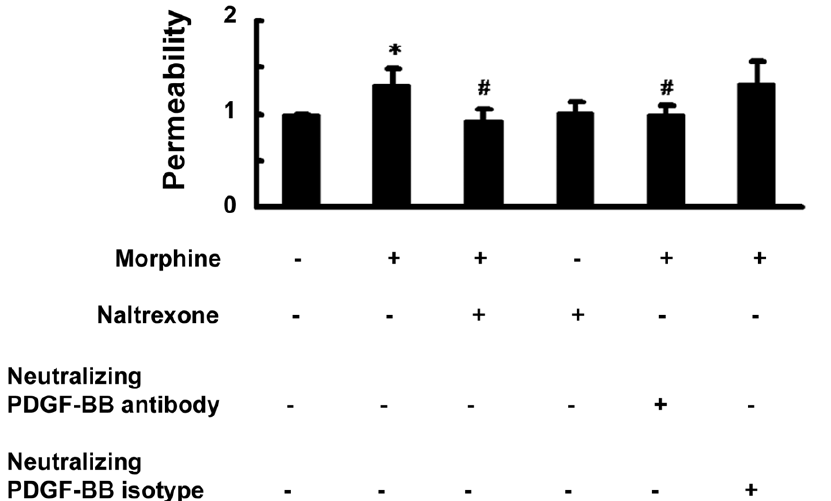
Figure 6. Effect of morphine on BBB permeability invitro . Morphine-mediated increase in BBB permeability was ameliorated in HBMECs pretreated with either naltrexone or PDGF-BB neutralizing antibody. All the data are presented as mean 6 SD of four individual experiments. *p , 0.05 vs control group; # p , 0.05 vs morphine-treated group.